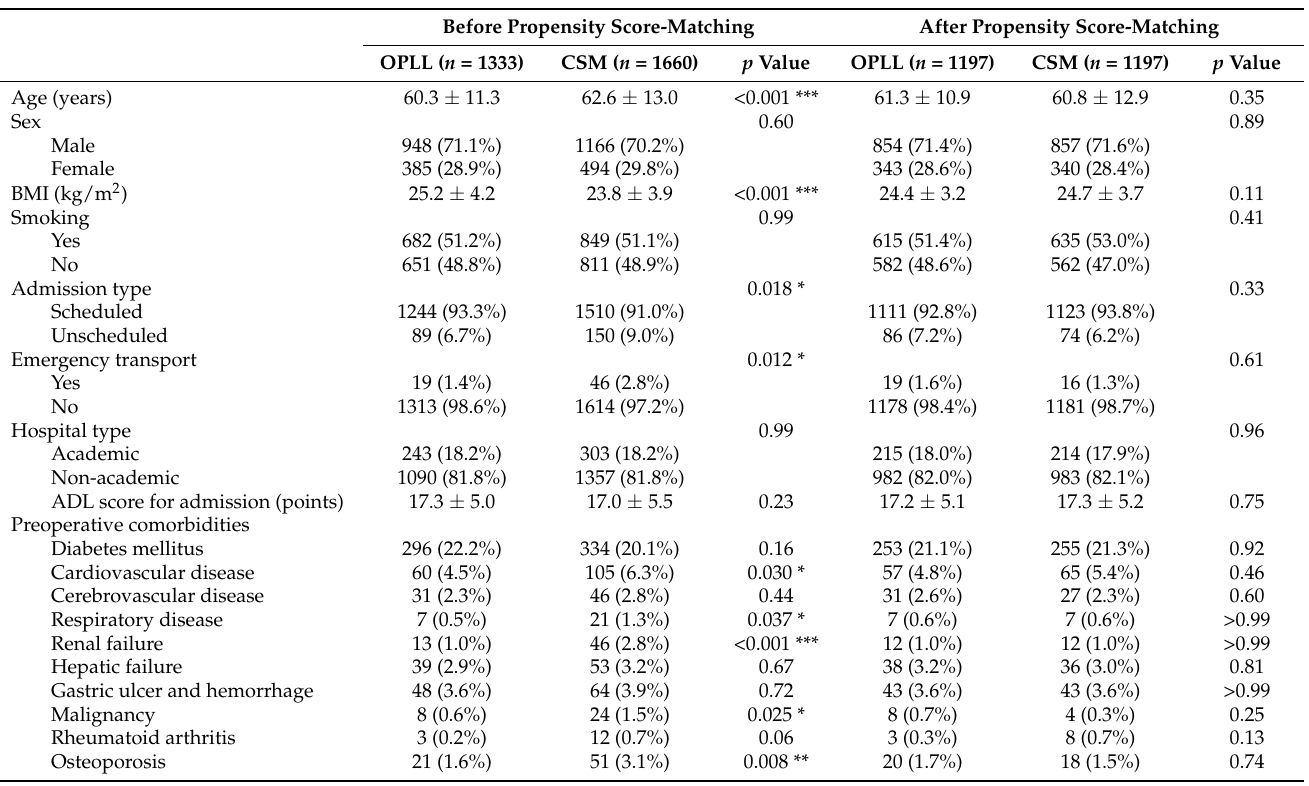
Table 1. Patient characteristics between OPLL and CSM before and after matching. Before Propensity Score-Matching